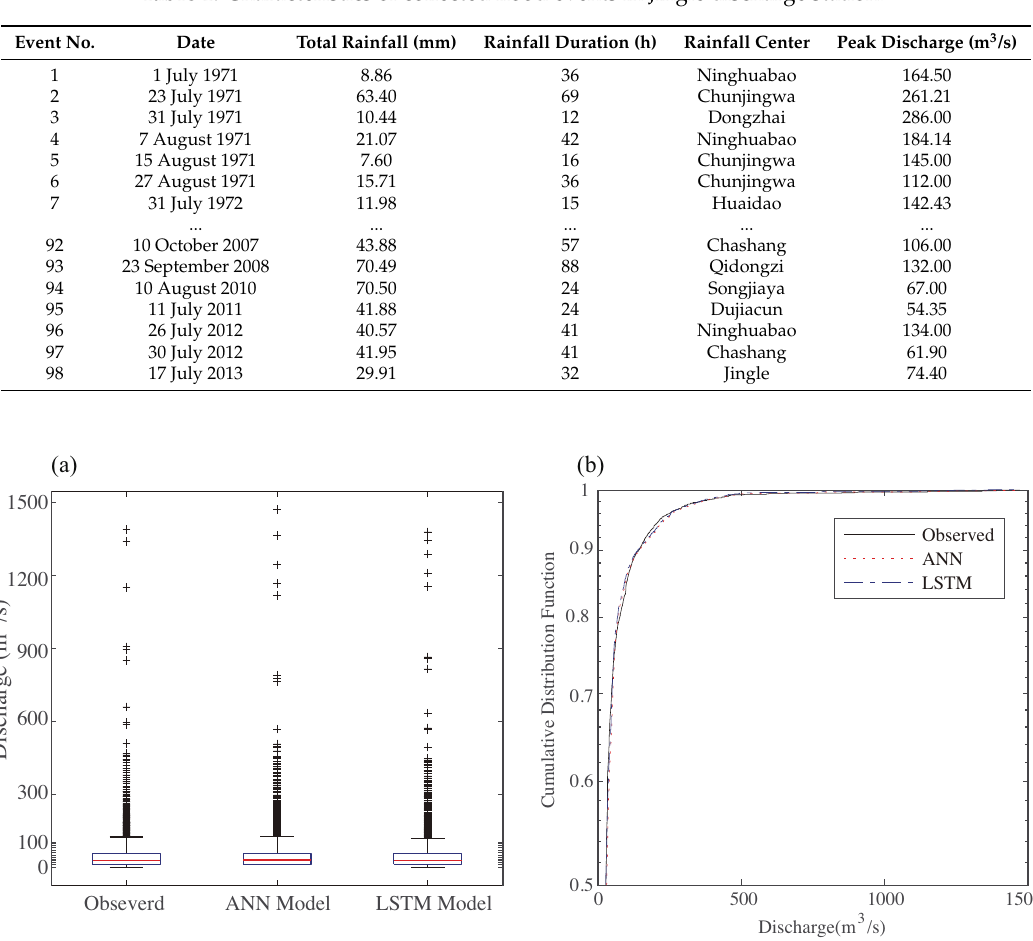
Figure 5. Box-plots ( a ) and cumulative distribution function ( b ) of observed and estimated discharge for the 12 flood events of validation using ANN and LSTM